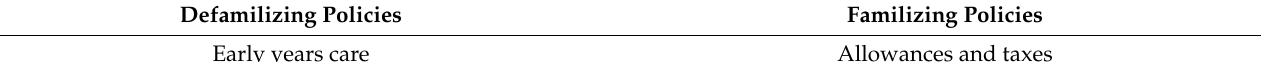
Table 1. Indicators used for defamilization and familization indices (Lohmann and Zagel 2016).